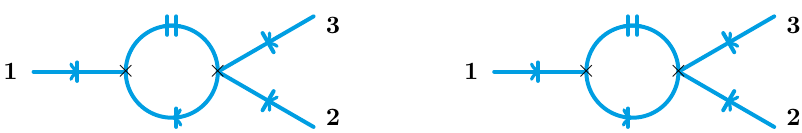
Figure 19. Renormalization of the Lindblad violating cubic coupling in the average-di(cid:11)erence basis.